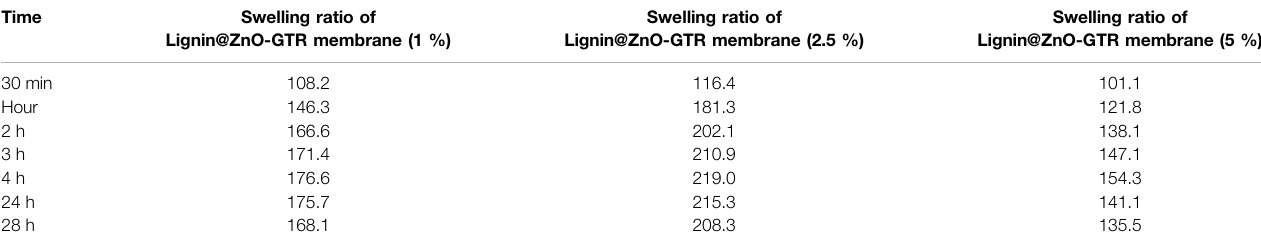
TABLE 3 | Membrane swelling degrees of various types of fabricated membranes. Time